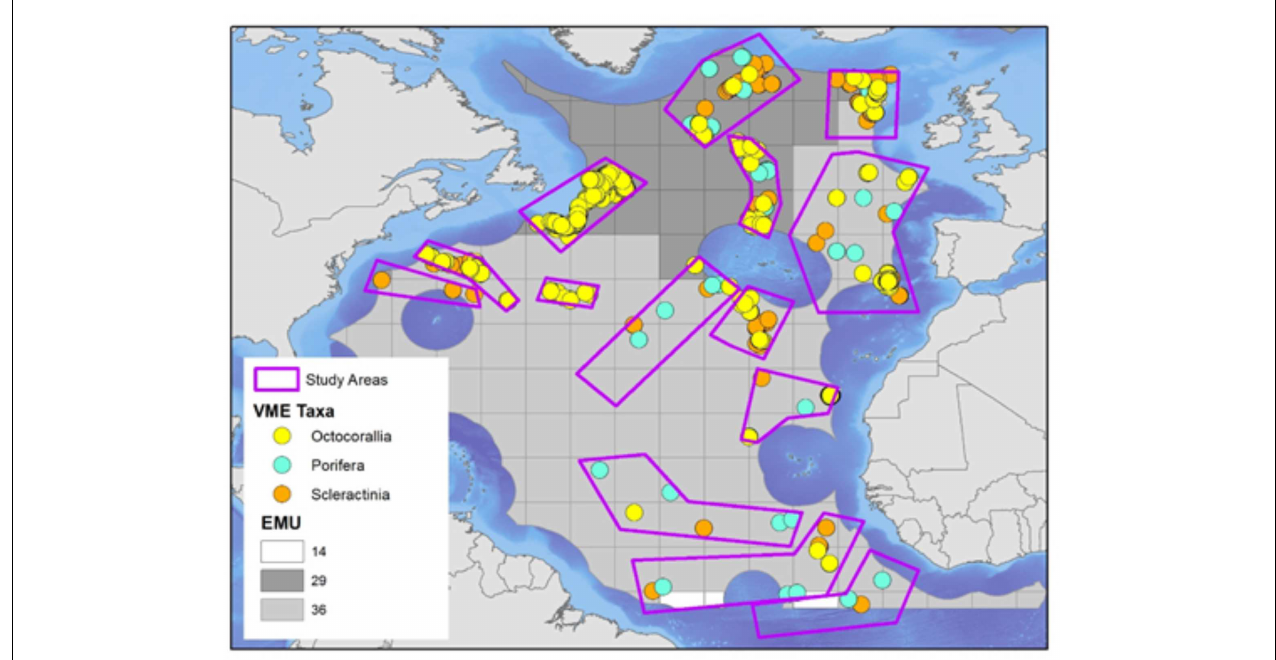
FIGURE 5 | EMUs were compared to species-based biogeographic clusters of vulnerable marine ecosystems (VMEs) in the North Atlantic. Three main VME-forming groups were selected: sponges (Porifera), stony corals (Scleractinia), and soft corals (Octocorallia).